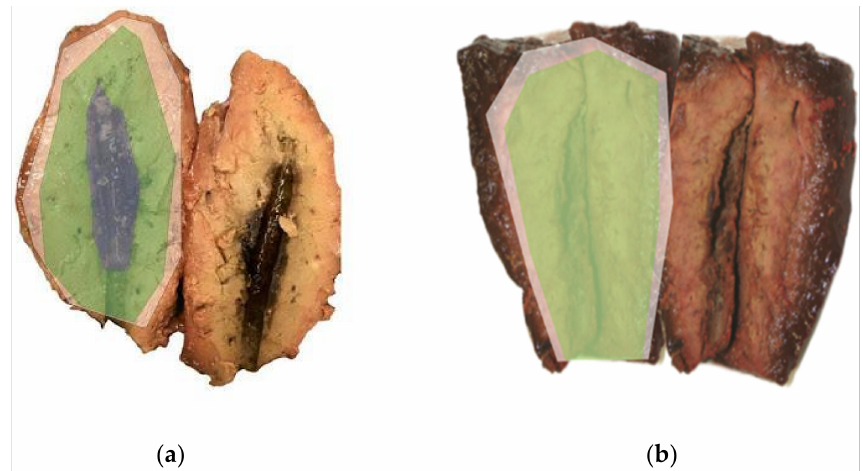
Figure 2. Cross section of the ablation zones in ( a ) the stand-alone applicator (25 W; 10 min) and ( b ) the spacer-supported applicator (25 W; 25 min). Black overlay: carbonisation zone. Green overlay: non-viable tissue. White overlay: total ablation zone (“red zone”).